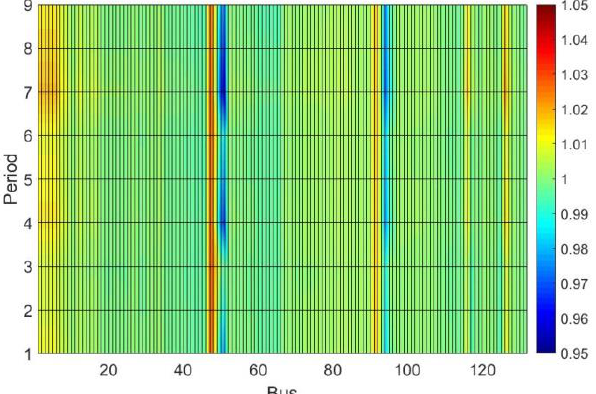
Figure 9. Continuous and discrete adjustment of taps, 20% PV.